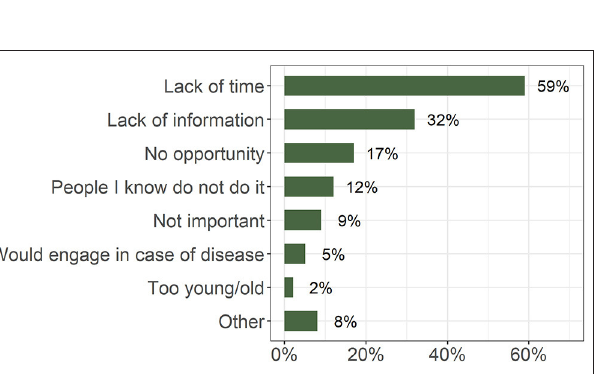
FIGURE 3 | Percentage of responses to the question “Why don’t you engage in healthy practices as much as you know would be good for you?” ( n = 945; multiple answers possible).